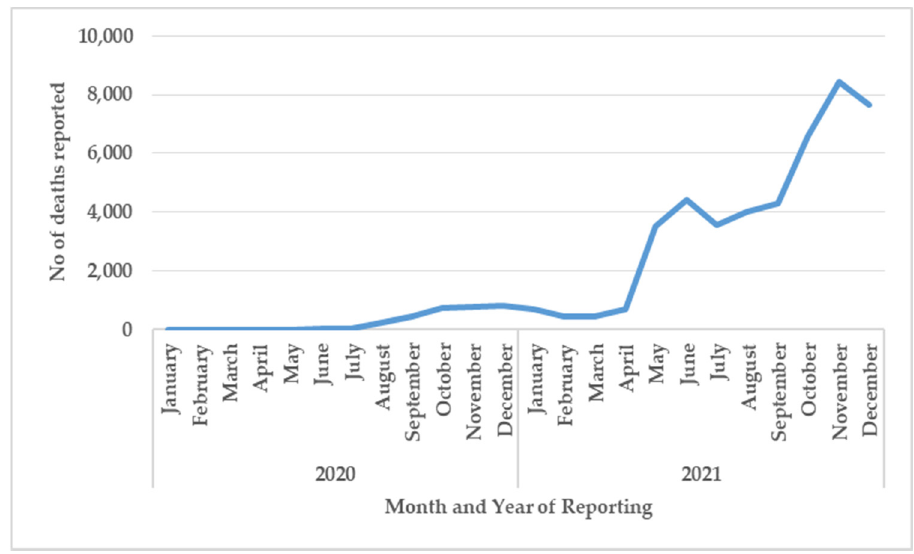
Figure 4. Number of monthly reported deaths due to COVID-19 in Kerala, 2020–2021. After June 2021, death reporting changed from a manual to an online system. After September 2021, deaths were defined as occurring within 30 days of COVID-19 test pos- itivity. After October 2021 families could also appeal to have missing COVID-19 deaths included in the